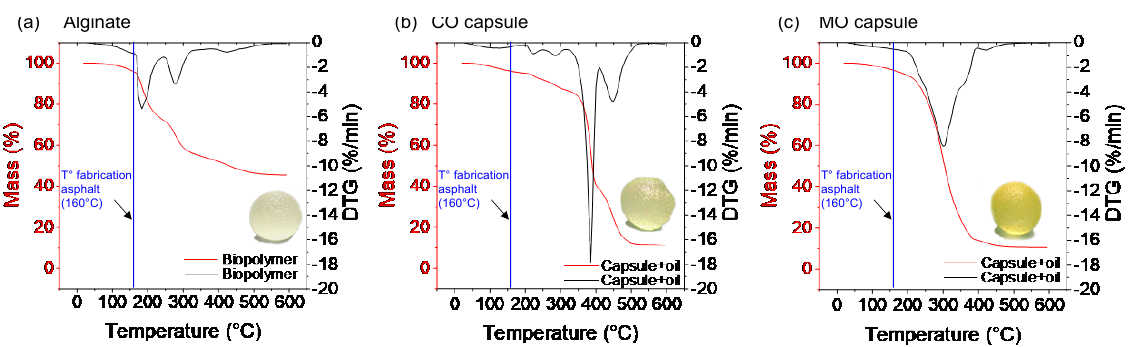
Figure 6. Thermogravimetric results for: (a) the alginate biopolymer used as encapsulating agent; (b) CO capsule; and (c) MO